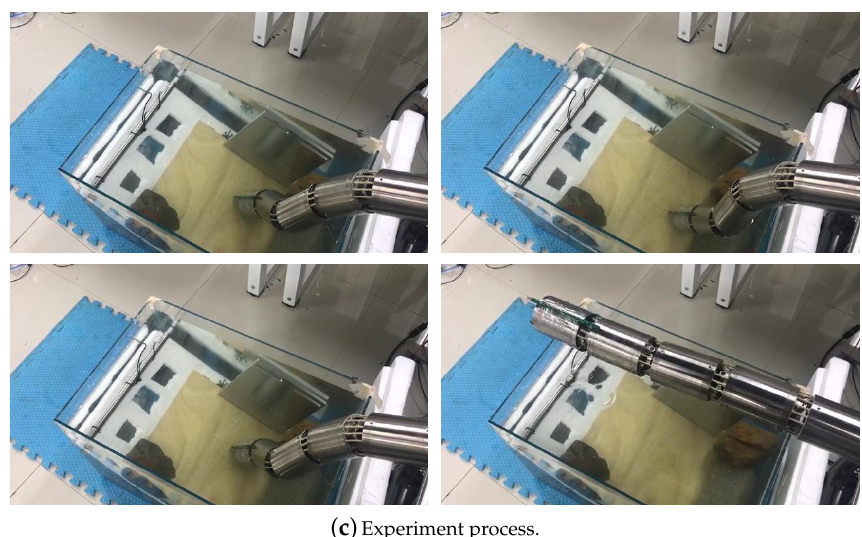
Figure 10. End-effector trajectory and experiment process of SET1 in the underwater environment.